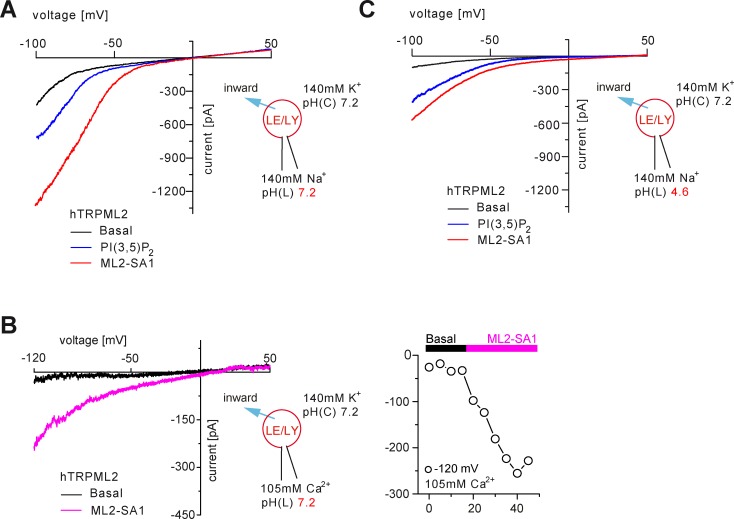
Effect of ML2-SA1 on TRPML2 under different pH conditions.(A) Representative basal, PI(3,5)P2 (1 μM) or ML2-SA1 (10 μM) elicited currents from YM201636-enlarged LE/LY isolated from hTRPML2 expressing HEK293 cells (neutral luminal pH). (B) Representative basal and ML2-SA1 (10 μM) elicited currents measured in 105 mM luminal Ca2+ (isotonic) from YM201636-enlarged LE/LY isolated from hTRPML2 expressing HEK293 cells. The right panel shows the corresponding time course. (C) Representative basal, PI(3,5)P2 (1 μM) or ML2-SA1 (10 μM) elicited currents from YM201636-enlarged LE/LY isolated from hTRPML2 expressing HEK293 cells (highly acidic luminal pH).